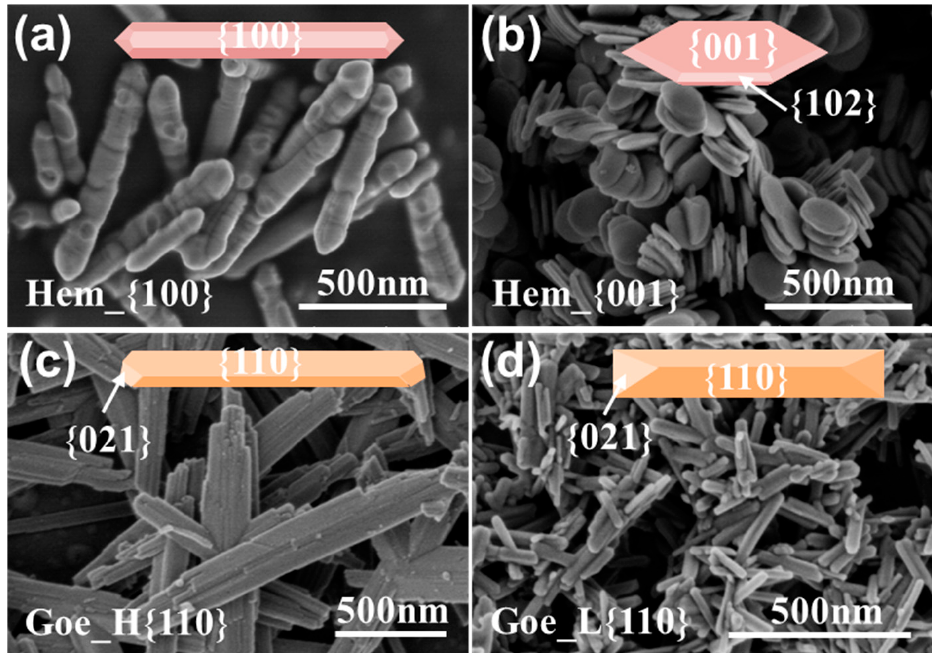
Figure 1. SEM images of synthetic iron oxide. ( a ) Hem_{100}, ( b ) Hem_{001}, ( c ) Goe_H{110}, and ( d ) ( d ) Goe_L{110}.